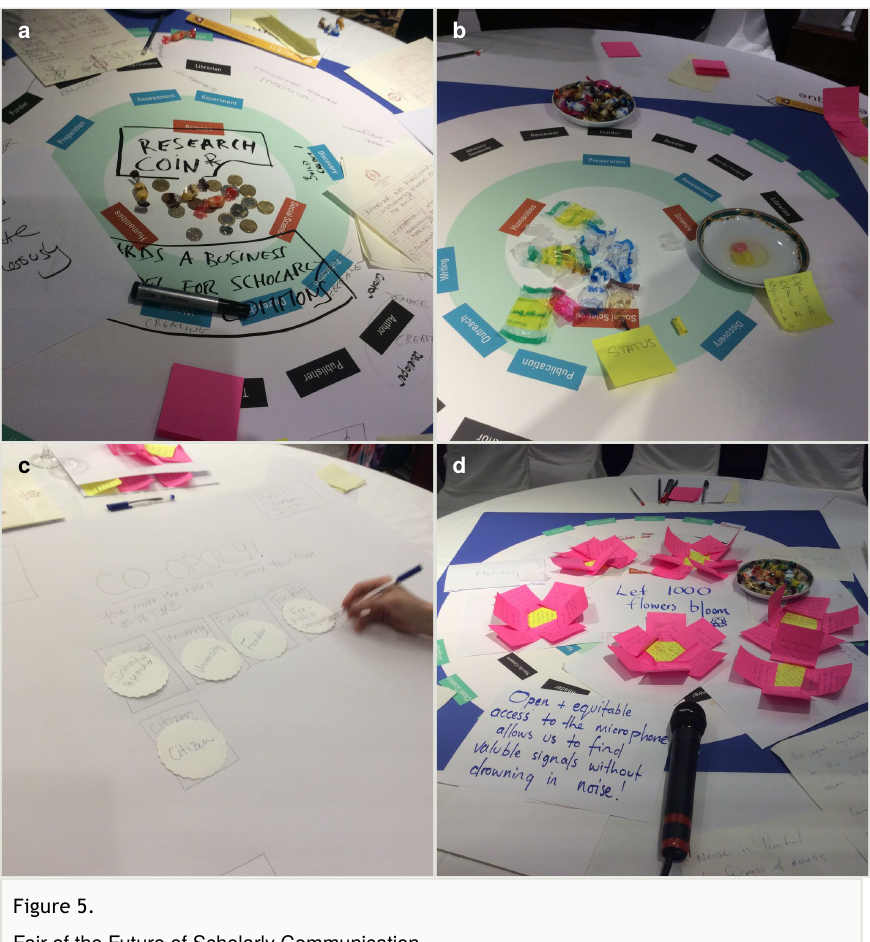
Figure 5. Fair of the Future of Scholarly